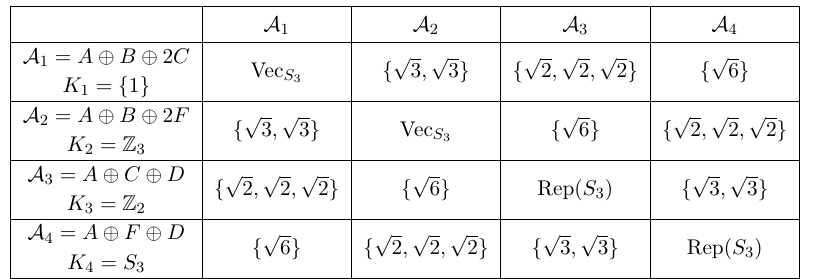
Table 4 . Summary of the distinct boundaries labeled by four different condensates A 1 , 2 , 3 , 4 , and the quantum dimension of defects/excitations localized between them. This is reproduced from [20]. The diagonal cells give the fusion category describing the boundary excitations of each type of